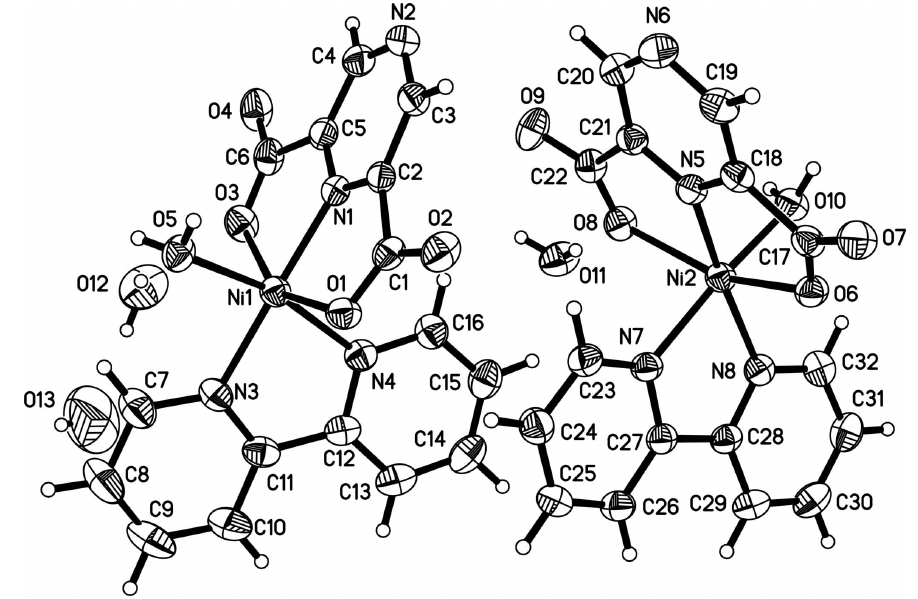
Figure 1 The asymmetric unit of the title complex. Dispacement ellipsoids are drawn at the 30% probability level.